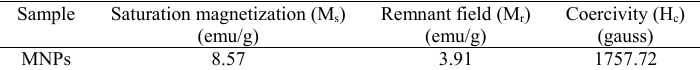
O @SiO catalyst before and after the reactions. 2 4 2 O @SiO nanoparticles by VSM 2 4 2